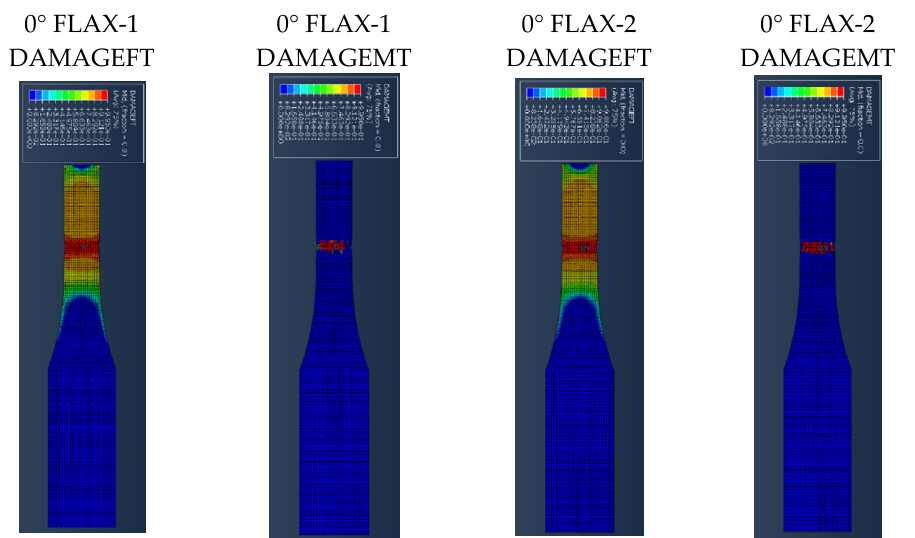
Figure 7. Damage evolution for fibres and matrix of top composite layers of Laminate A at 2.6 mm displacement.